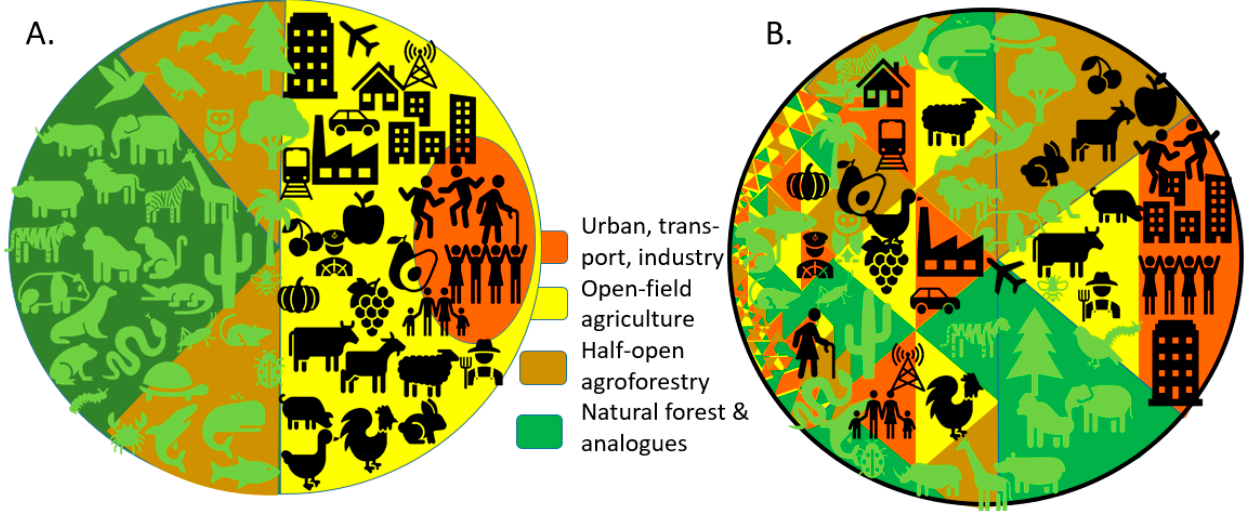
Figure 10. Visualization of the half earth debate and two contrasting spatial ways of achieving it: ( A ). through spatial segregation minimizing the nature–human interface and maximizing space for species with low compatibility with humans, or ( B ). through spatial integration with more intensive nature–human contact and proximity.